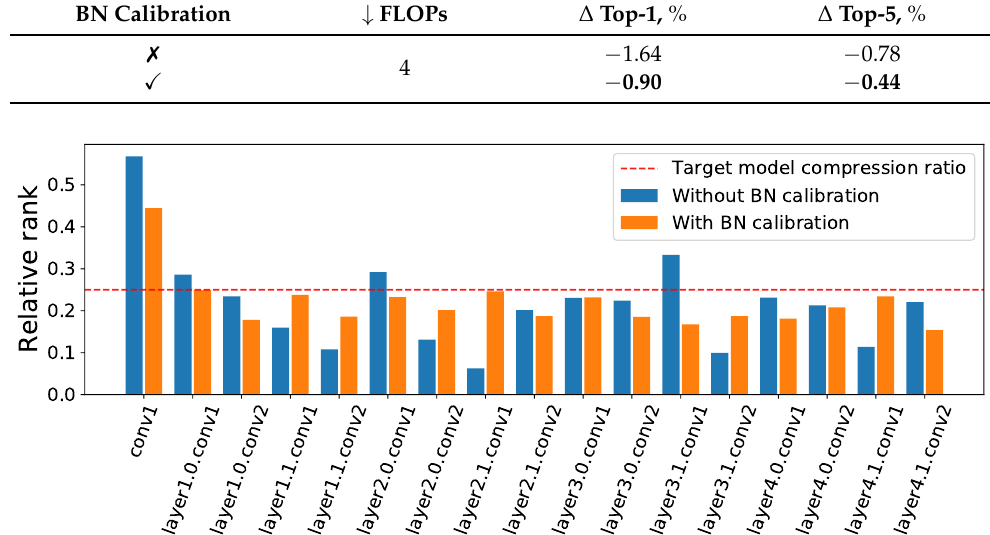
Figure 8. Visualization of related ranks found by the PARS algorithm for different FLOP compre- ssion ratios. Table 2. Comparison of the performance of PARS with and without the calibration of the BN statistics. The FLOPs column denotes the compression of the computations; the ∆ top-1 and ∆ top-5 columns ↓ denote the top-1 and top-5 accuracy losses—the higher, the better.